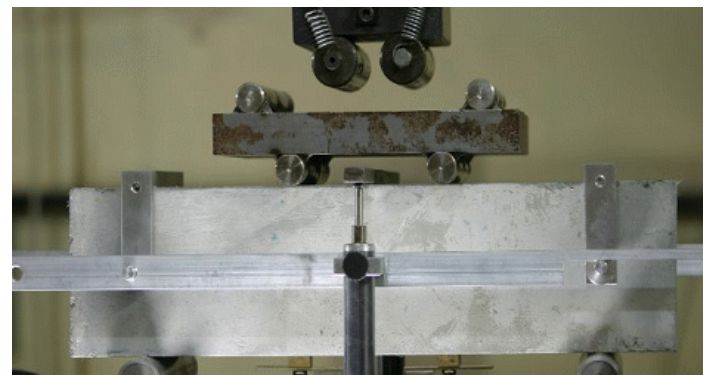
Figure 4. Test setup for four-point flexural test.